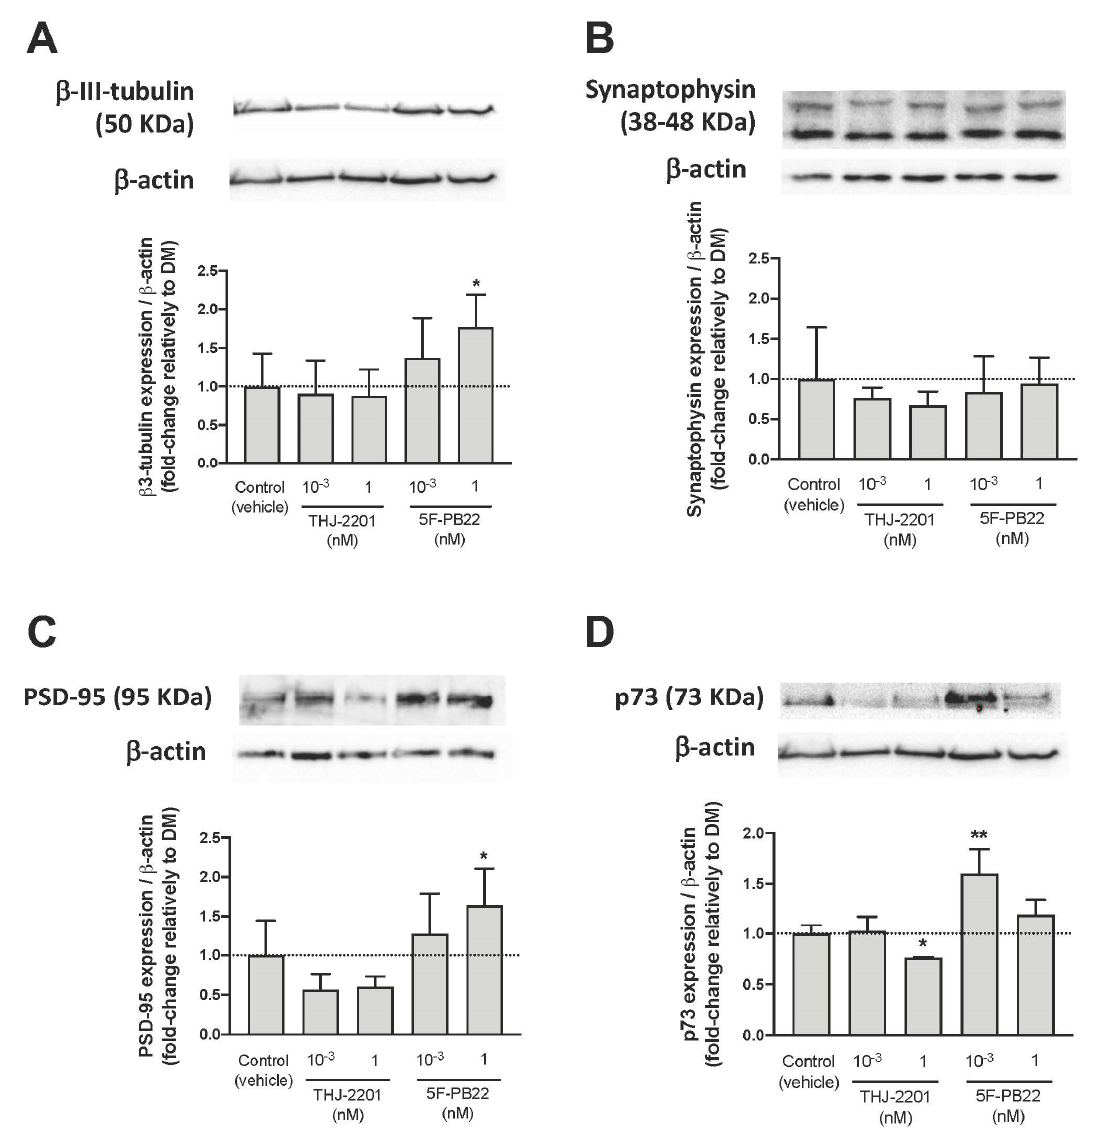
Figure 7. Expression of neuronal markers. Neuronal di ff erentiation was performed according to the procedure described in Materials and Methods. After 72 h of di ff erentiation and cell treatment with either a single addition of THJ-2201 (1 pM or 1 nM) or repeated (three) additions of 5F-PB22 (1 pM or 1 nM), the expression of ( A ) β 3-tubulin (50 KDa), ( B ) synaptophysin (38–48 KDa), ( C ) PSD-95 (95 KDa), and ( D ) p73 (73 KDa) was assessed by Western blot. Representative protein bands and graphical representations of band intensities, expressed as the percentage of protein expression relatively to the vehicle-treated control, are shown for each protein. Their expression was normalized by the amount of β -actin per lane. Each bar represents the mean ± SD, for at least four independent experiments. * p < 0.05, ** p < 0.01, compared to control (vehicle), using a one-way ANOVA, followed by Dunnett’s post-test.